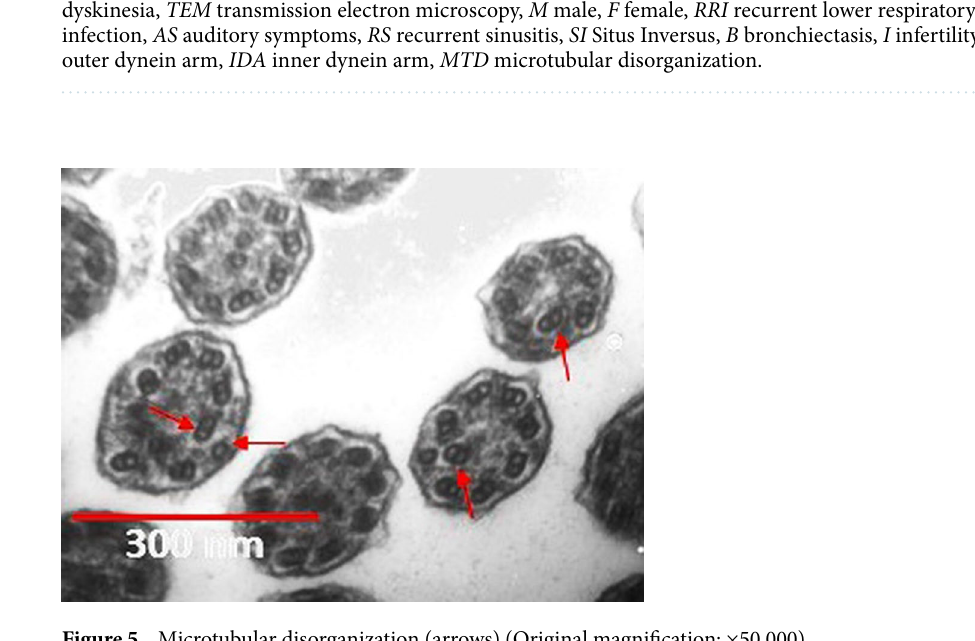
Table 2. Clinical presentations and TEM findings among confirmed cases of PCD. PCD primary ciliary dyskinesia, TEM transmission electron microscopy, M male, F female, RRI recurrent lower respiratory